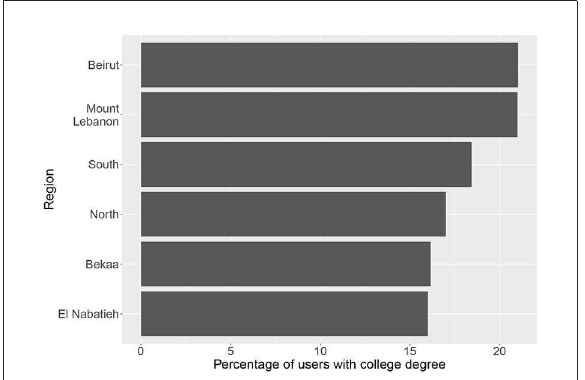
FIGURE8 Percentage of Facebook users from the refugee community aged 13+ with self-declared college education across different governorates of